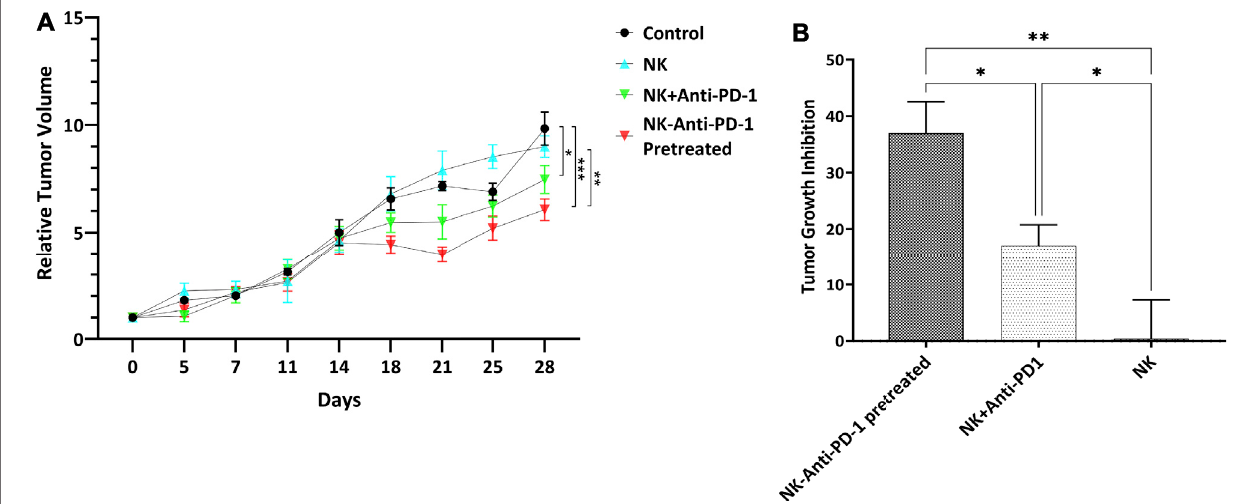
FIGURE 4 | Morphometric growth characteristics. (A) RTV versus the elapsed time curve showed tumor growth variations. (B) Tumor growth inhibition of interventions normalized with control tumor. Data presented as means ± standard error (M ± SE). Statistical signi fi cance was determined using 2-way ANOVA with * p < 0.05.